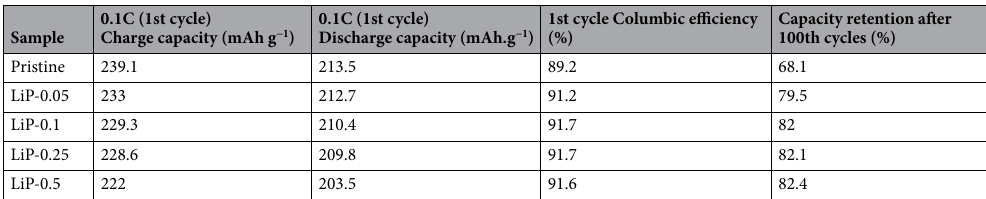
Table 2. Electrochemical capacities and retention of pristine and LiP-NCM cathode samples.